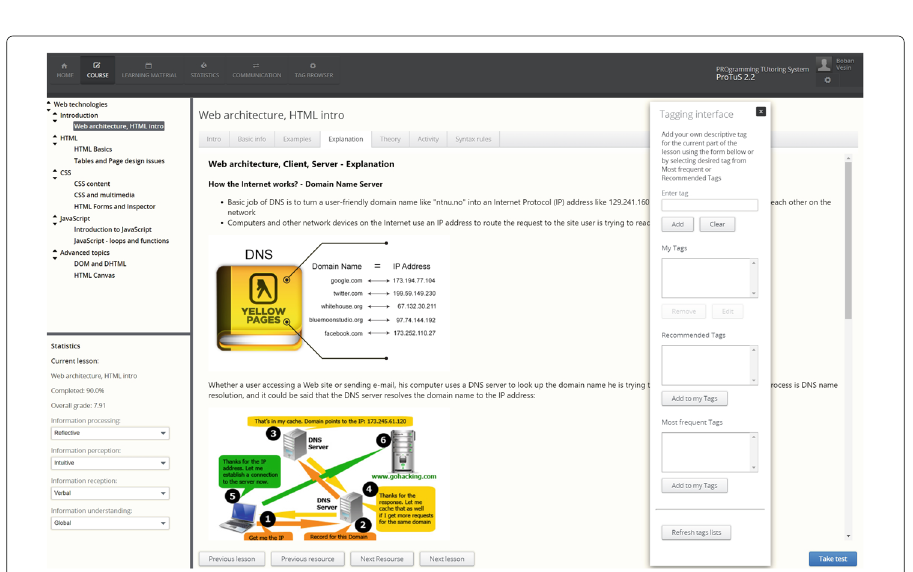
Fig. 2 User interface of